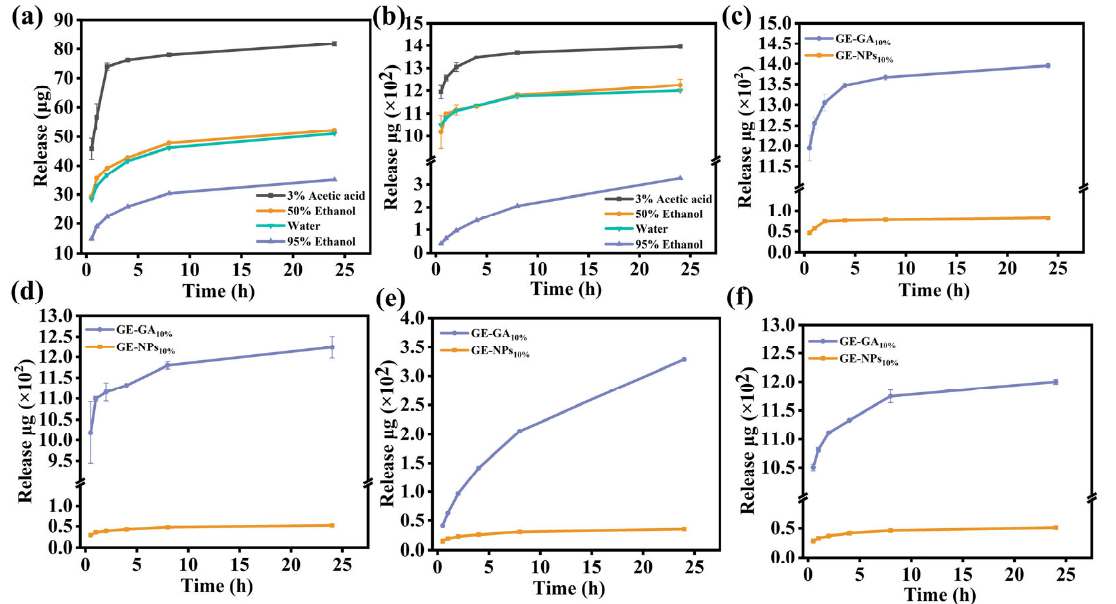
Figure 4. ( a , b ) Release assay of GE-NPs 10% coating and GE-GA 10% coating in simulated solution; ( c – f ) Release assay of GE-NPs 10% coating and GE-GA 10% coating in 3% acetic acid, 50% ethanol, 95% ethanol, and water.